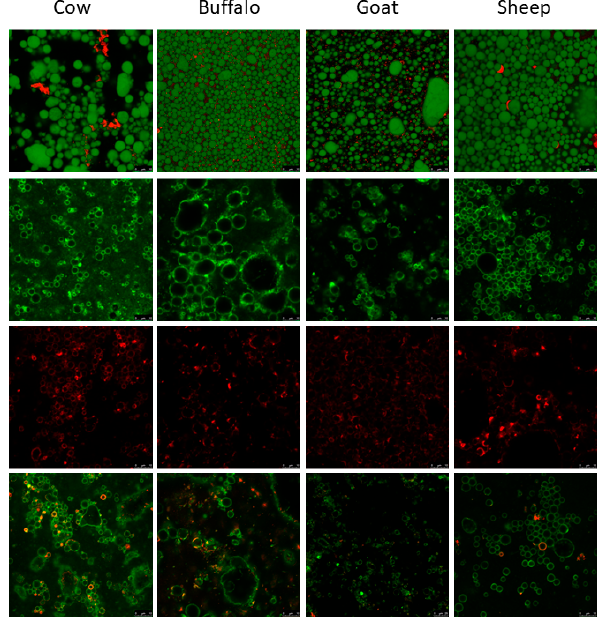
Figure 5. Row 1: Confocal micrographs showing milk fat globules stained with Nile Red (Green) and Fast Green FCF (red). The triacylglycerol core of the fat droplets is stained with Nile Red (green spheres) and the red indicates interfacial proteins. Row 2: Emission fluorescence of Rh-PE dye (green). The surface of fat droplets stained with Rh-PE indicating phospholipid coatings in the samples. Row 3. Emission fluorescence of WGA Alexa Fluor 488. Glycosylated molecules such as sugar residues from glycoproteins and glycolipids are shown by staining with WGA (red). Row 4. Confocal micrographs showing fluorescence emission of both the fluorescently labelled phospholipid Rh-PE (green) and lectin wheat germ agglutinin (red). Scale for all images = 10 µm. Column A = Cow cream, Column B = Buffalo cream, Column = Goat cream and Column D = Sheep cream.